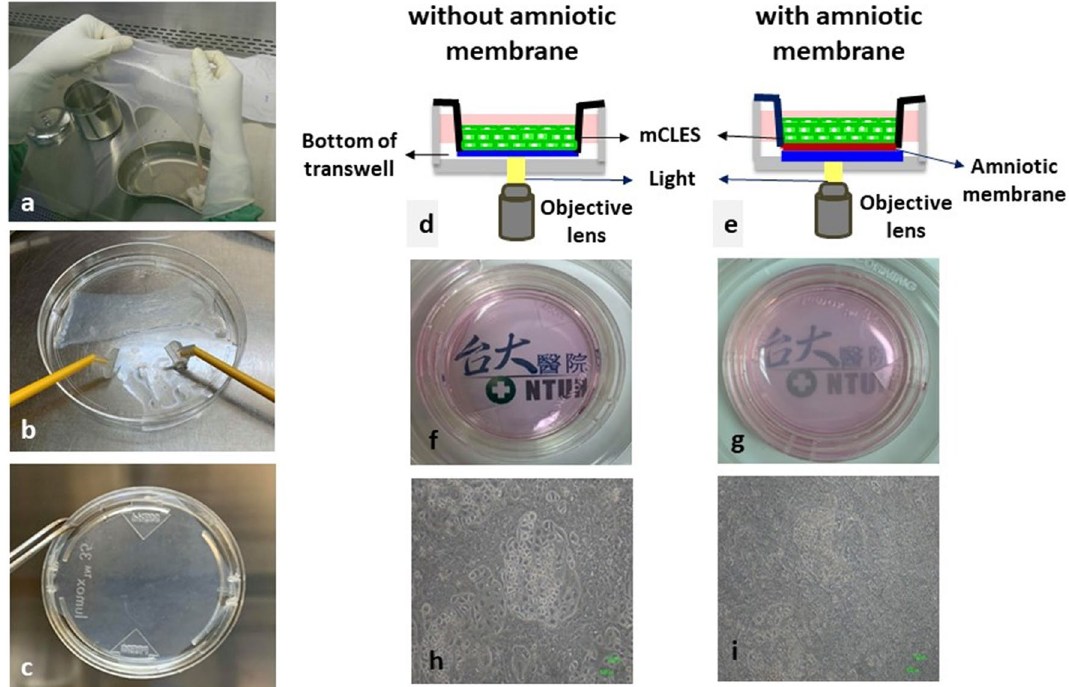
Figure 3. The preparation of the semitransparent amniotic membrane (stAM) as the matrix for cell culture, and the effects of the stAM on inverted microscopy imaging quality impairments. ( a–c ) The harvest of the stAM and the preparation as the matrix for cell culture in a transwell. ( d , e ) The spatial relationship of the stAM, bottom of the transwell, cultivated cells, objective lens of the FF-OCT, and light emitted for obtaining images. ( f , g ) The stAM was semitransparent and reduced light transmission, and both transwells were added to the culture medium. ( h , i ) The stAM reduced the imaging quality of cultivated cells under a phase-contrast inverted light FF-OCT (Fig. 2d,f,h) and immunocytochemical staining results obtained using in vitro confocal microscopy (Fig. 2c,e,g). Our FF-OCT provided high-quality sequential images captured from different layers that clearly demonstrated the squamous morphology in superficial layers (Fig. 2d), the wing cell morphology in middle cell layers (Fig. 2f), and the cuboidal morphology in basal cell layers (Fig. 2h). We quantified the cell densi- ties in immunocytochemistry (ICC) images and in their corresponding FF-OCT images, and compared the results of these 2 imaging modalities at 3 different layers, namely corneal superficial, wing, and basal layers. The cell densities in ICC images were similar to that in FF-OCT images among all layers, including superficial (ICC: 1160 ± 115.33; OCT: 1150 ± 170.88 cells per millimeter square, p = 0.94), wing (ICC: 1987 ± 177.86; OCT: